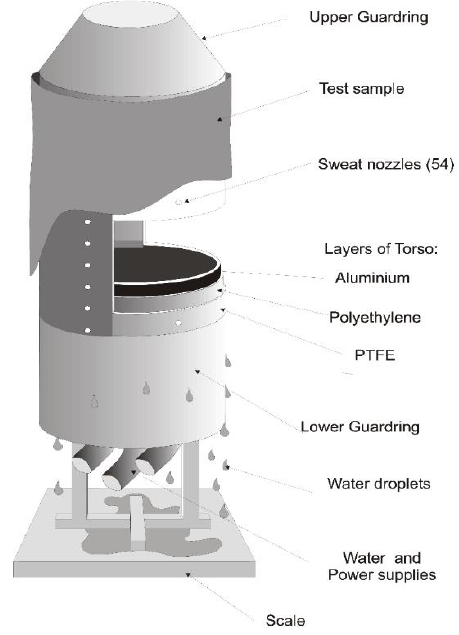
Figure 1. Schematic illustration of sweating